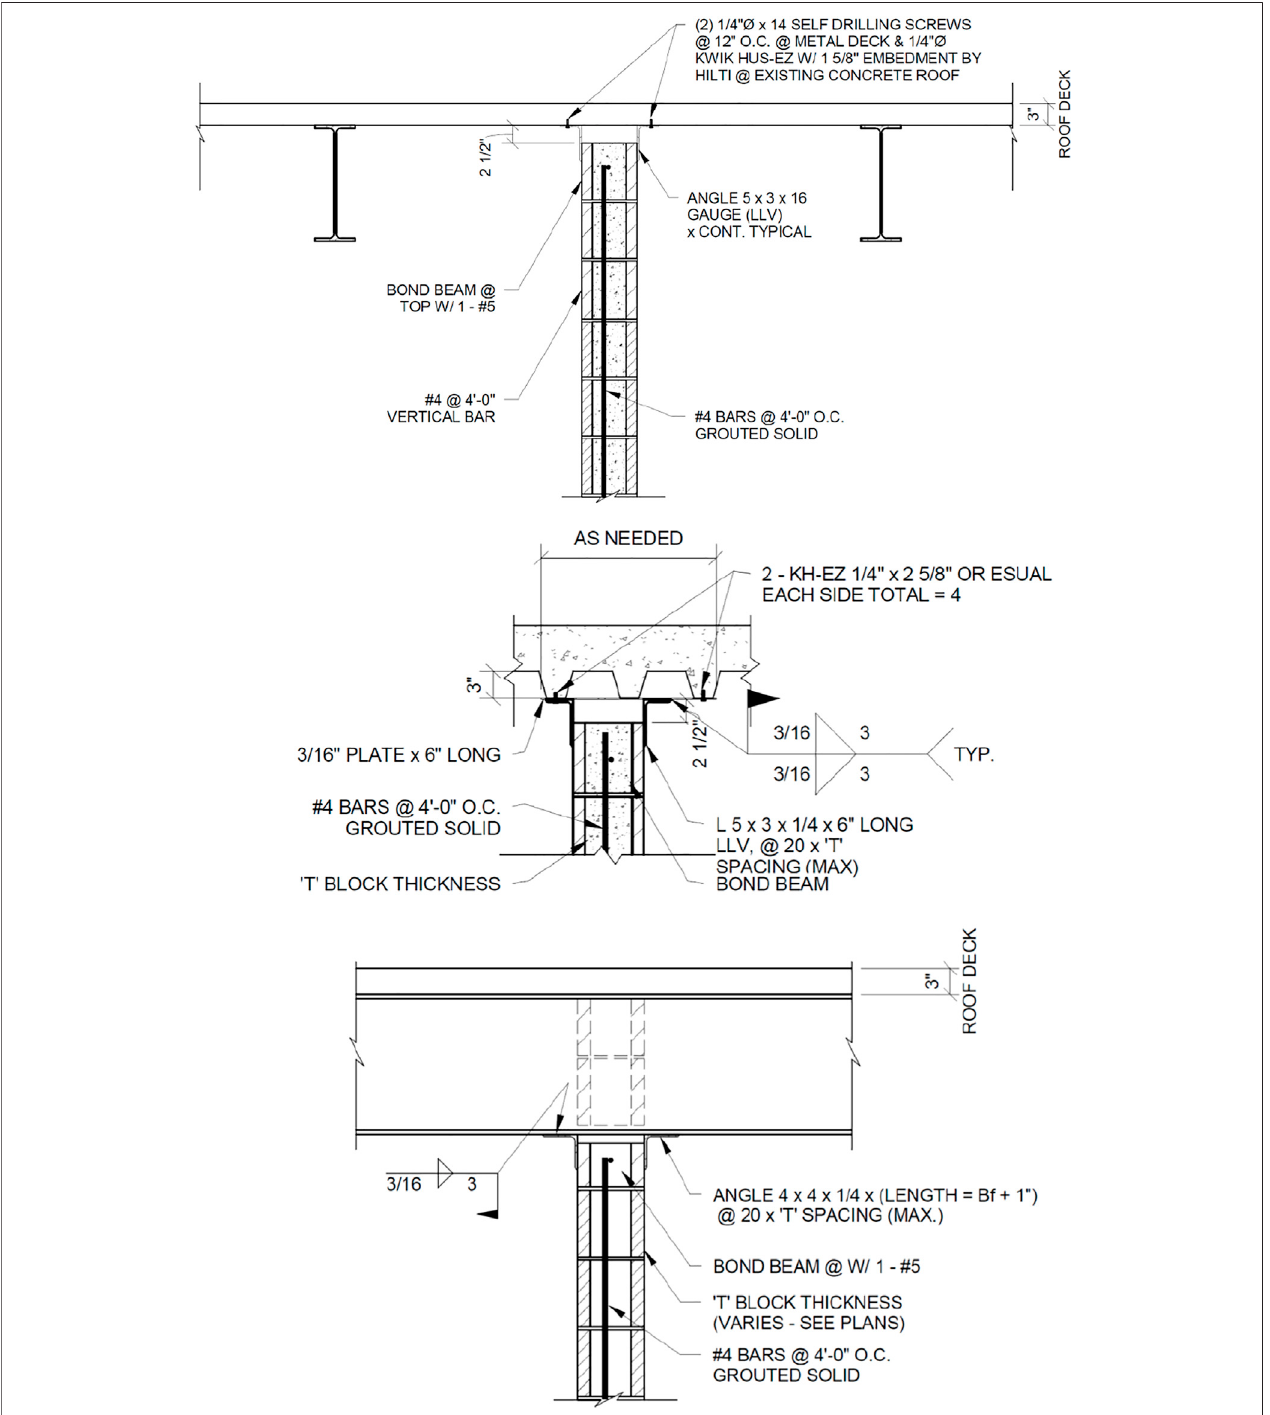
FIGURE 12 | Non-load-bearing wall details of the test